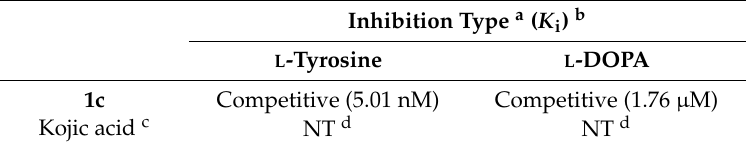
Table 2. Enzyme kinetic analysis of 1c against mushroom tyrosinase.